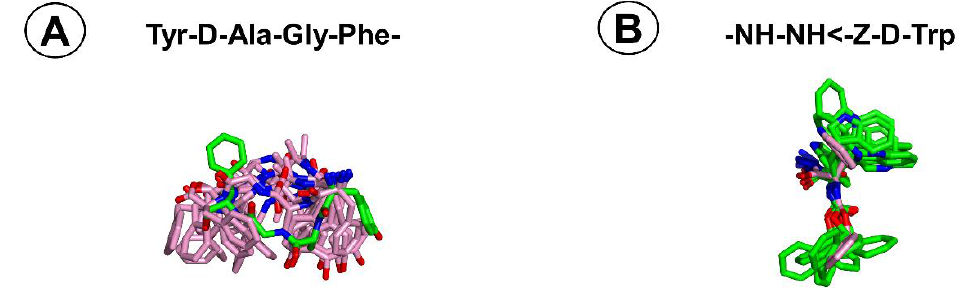
Figure 10. Superposition of the AA3266 conformations found in simulations with MOR and NK1R ( A ) Focus on the Tyr- D -Ala-Gly-Phe- fragment, ( B ) Focus on the -NH-NH-Z- D -Trp fragment. Green sticks represent the structures from simulations with MOR, and pink sticks represent the structures from simulations with NK1R. The reference structures are MOR-1 for ( A ) and NK1-a for ( B ) as the most populated clusters at the respective receptors.